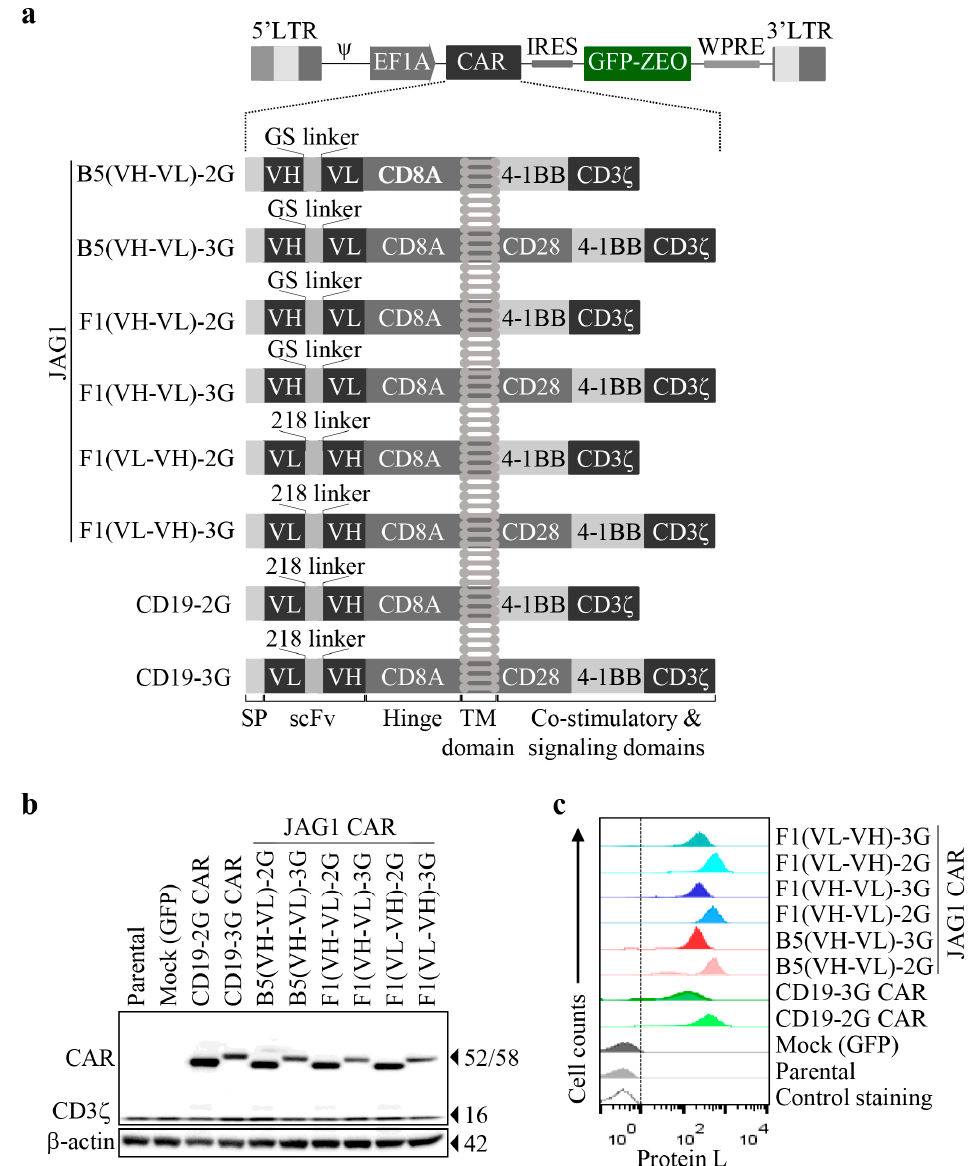
Figure 3. Design of CAR constructs and evidence of CAR expression in transduced Jurkat T cells. ( a ) Schematic representation of functional regions of generated lentiviral CAR constructs used to obtain engineered T cells. After lentivirus transduction, effector cells expressed one of the depicted CARs consisting of the GMCSF signal peptide (SP) and the variable light (VL) and variable heavy (VH) chains of the scFv from J1.B5 or J1.F1 Abs (anti-JAG1 B5 or F1 CARs) or from FMC63 (anti-CD19 CARs), the flexible linkers 218 or (GGGGS) 3 , the hinge and transmembrane (TM) domain of CD8A, the CD28 and/or 4-1BB as costimulatory domains, and the CD3 ζ cytoplasmic domain of T cells; zeocin–GFP fusion protein enabled detection and selection of CAR-transduced cells. Ψ (psi), sequence for packaging the viral genome into the capsid. ( b,c ). CARs expression on Jurkat cells. Cells were transduced with control (mock) or one of the different CAR lentiviral vectors. ( b ) Immunoblotting analysis of CAR expression 72 h post-transduction. Detection of β -actin was used as loading control. ( c ) Flow cytometry plots showing surface expression of CARs in Jurkat cells after zeocin selection of transduced cells detected by binding to protein-L. Nontransduced/parental and mock-transduced cells were used as controls.